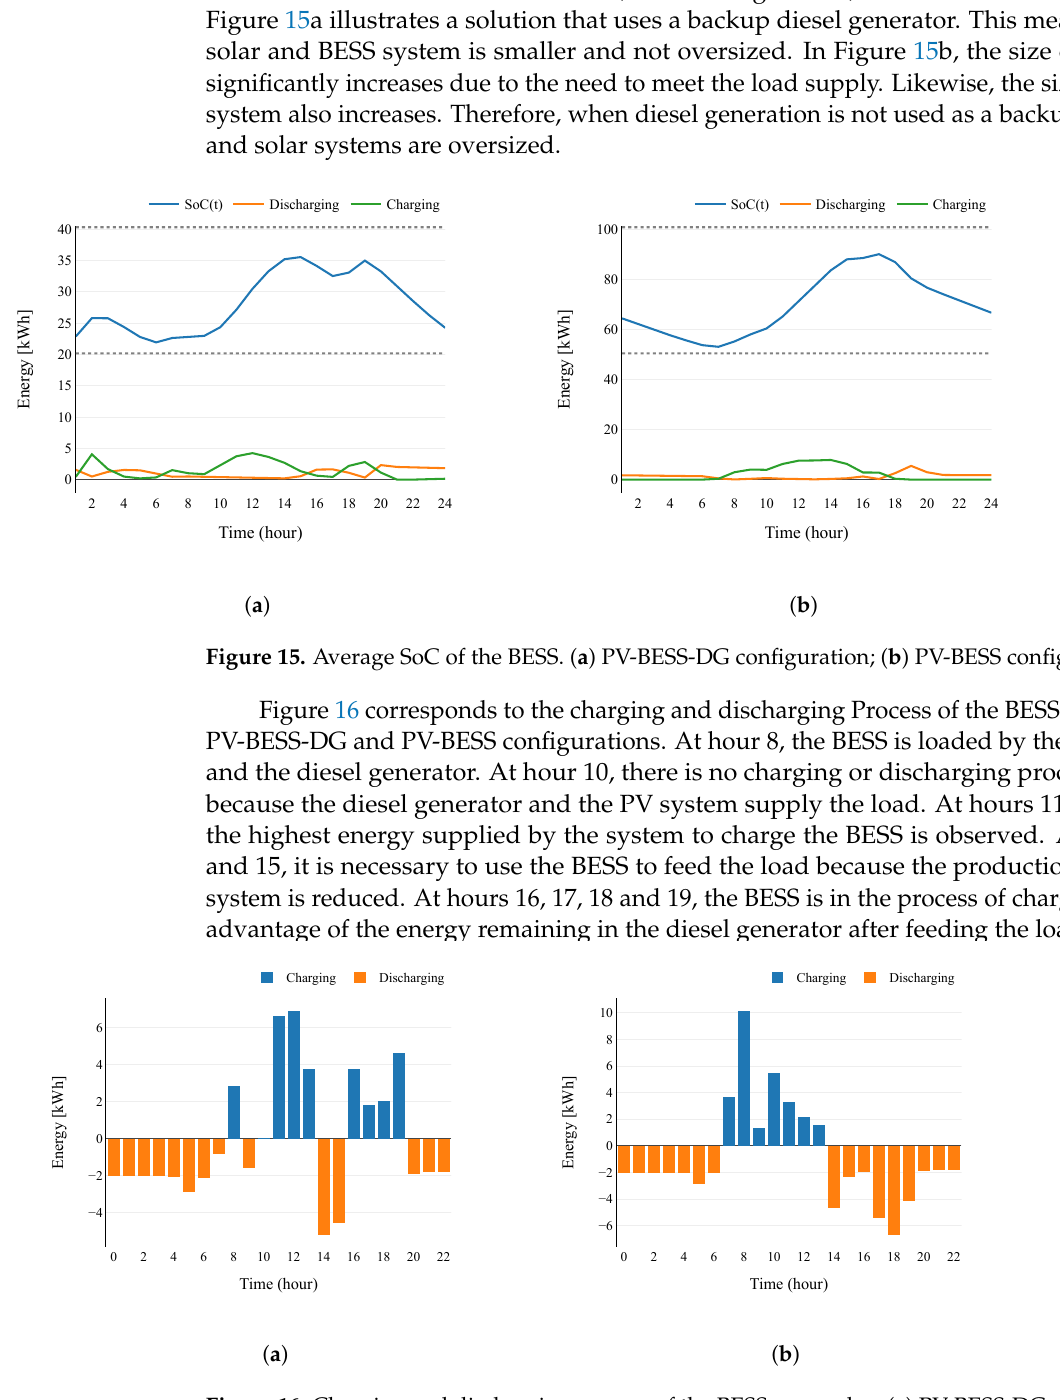
Figure 16. Charging and discharging process of the BESS over a day. ( a ) PV-BESS-DG configuration; ( b ) PV-BESS